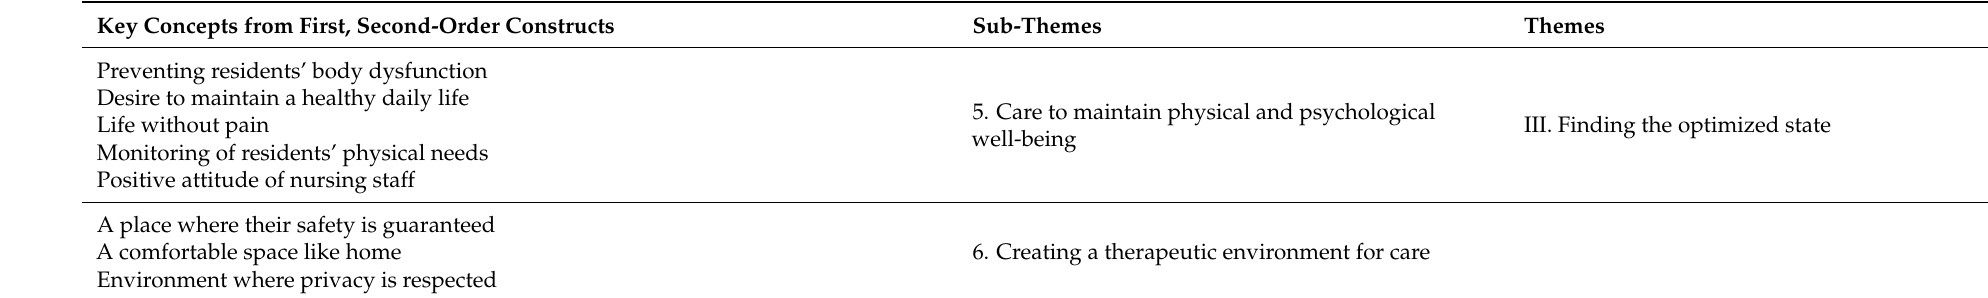
Table 3. Cont. Key Concepts from First, Second-Order